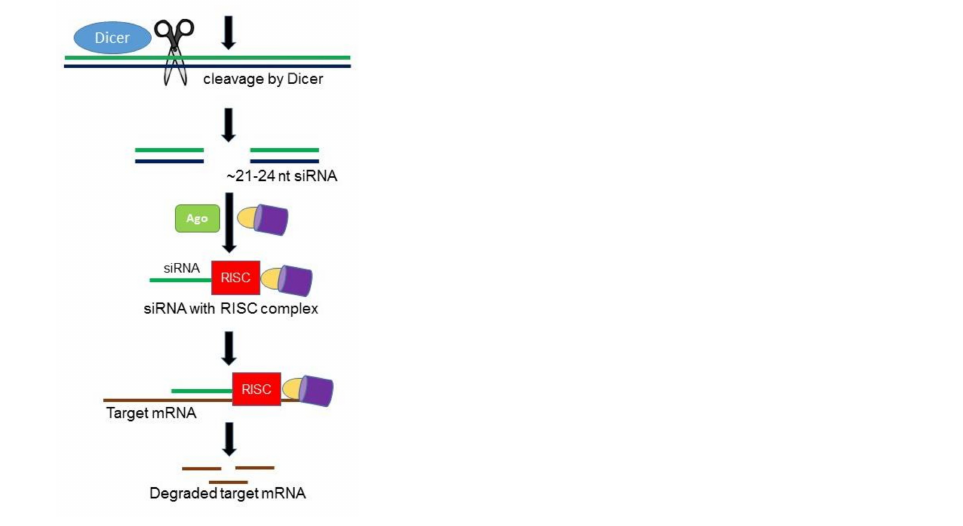
Figure 1. Hypothetical model of RNA interference (RNAi) pathway in fungi. The Dicer ribonuclease III enzyme (DCR) cleaves exogenous long double-stranded RNA (dsRNAs) into ~21–24 nucleotide small interfering RNAs (siRNAs). The guide siRNA then loaded onto the major catalytic compo- nent called Argonaute (Ago) and other proteins generating the RNA-induced silencing complex (RISC). siRNA, along with RISC, complementarily pair with messenger RNA (mRNA) resulting in degradation of